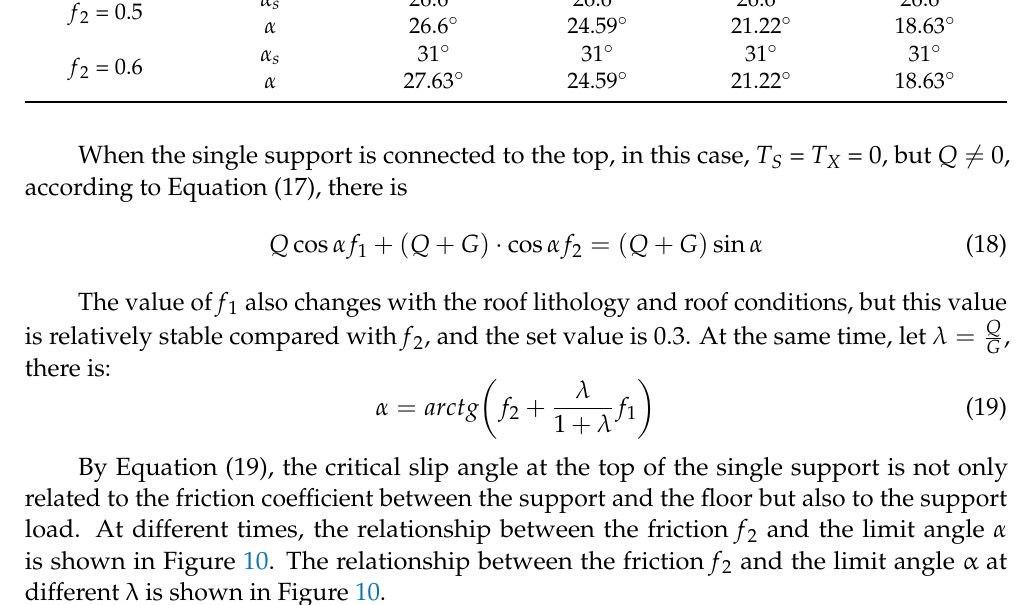
Table 2. Relationship between support – floor friction f 2 and critical angle α of lateral stability of sin- gle support.